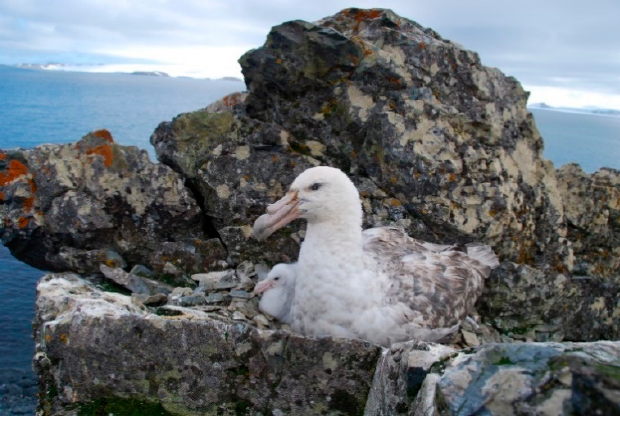
Figure 1. The southern giant petrel Macronectes giganteus .